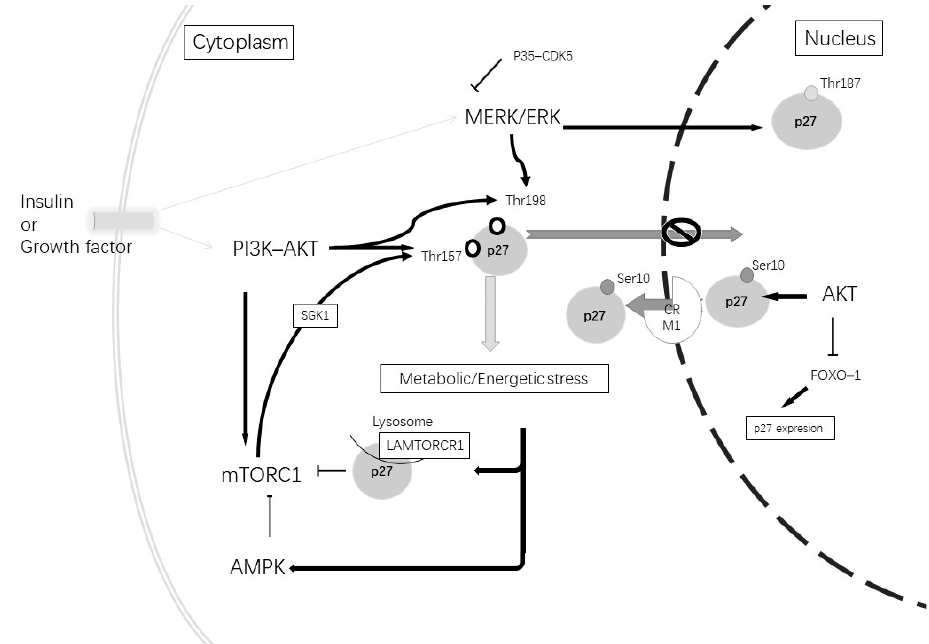
Figure 3. Insulin or growth factors can stimulate tyrosine kinase inducing the activation of the (a) MERK-ERK and (b) PI3K-AKT pathways. The activation of the MERK-ERK pathway stimulates p27 Kip1 phosphorylation at Thr187, which induces its degradation. Its phosphorylation at Thr198 produces p27 Kip1 cytoplasmic retention. The MERK-ERK pathway can be inhibited by p35 and the CDK5 complex. The activation of the PI3K-AKT pathway causes mTORC1 activation and causes phosphorylation at Thr157 through SGK1. Furthermore, AKT can phosphorylate at Thr198 and Thr157, which causes p27 Kip1 cytoplasmic retention. AKT at a nuclear level phosphorylates Ser10, promoting p27 kip1 nuclear export and can induce the inhibition of FoxO1 TFs and repress the gene expression of p27 Kip1 . A metabolic or energetic stress condition induces mTORCR1 inhibition by the induction of p27 Kip1 binding to LAMTORCR1 and AMPK pathway activation. In addition, AMPK phosphorylates p27 Kip1 at Thr198.